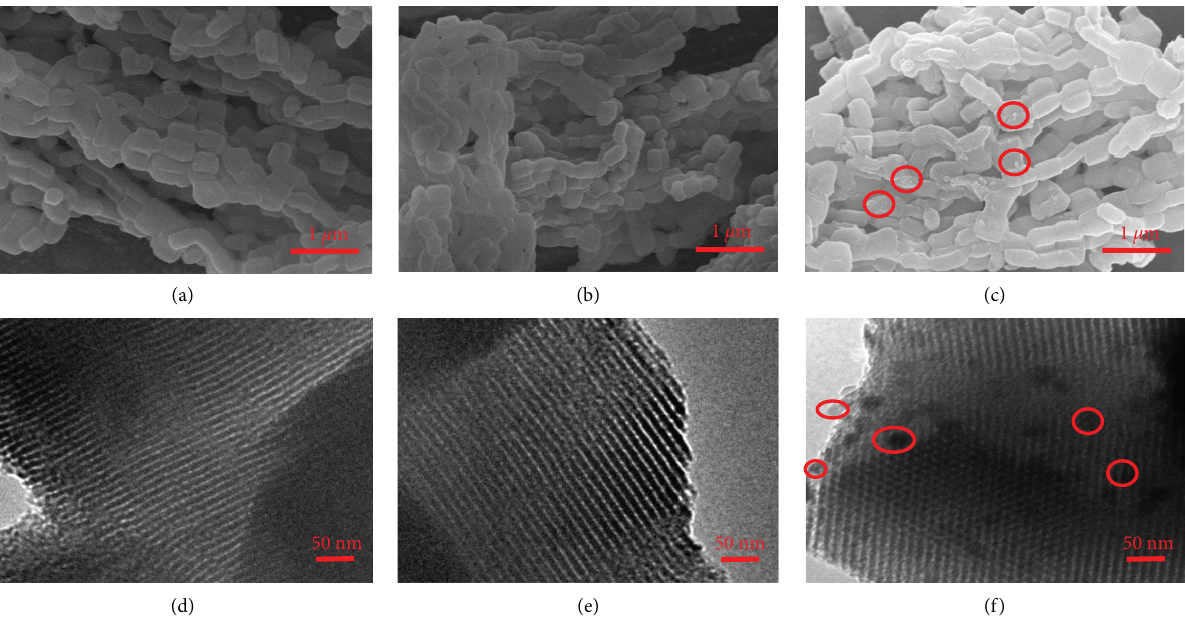
Figure 5: Te FESEM images of SBA-15 (a), NH 2 -Pr-SBA-15 (b), and E–NH 2 –Pr-SBA-15 (c) and HRTEM images of SBA-15 (d), NH 2 -Pr- SBA-15, (e) and –NH 2 –Pr-SBA-15